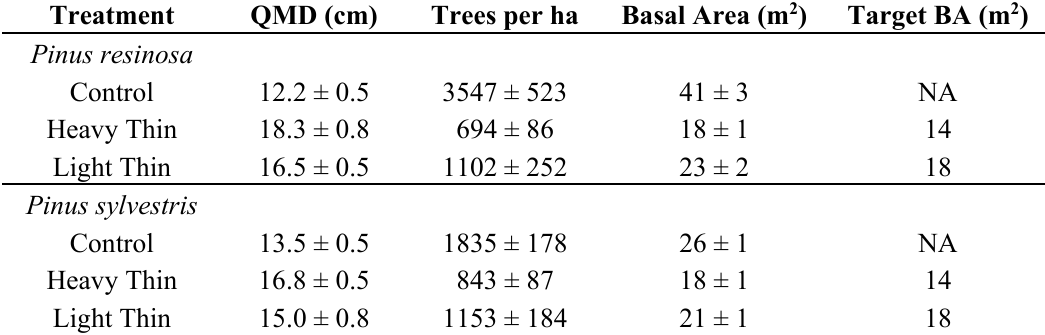
Table 1. Quadratic mean diameter (QMD), trees per hectare, basal area, and target basal area for control and treatment blocks in P. resinosa and P. sylvestris